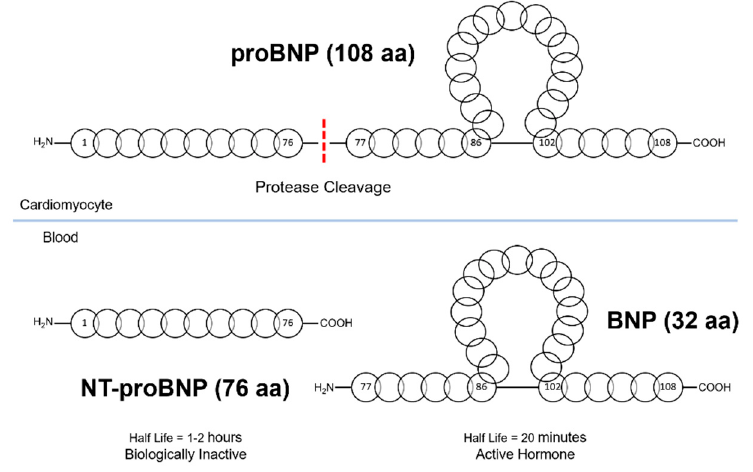
Figure 1. The biochemistry of B-Type natriuretic peptide expression.